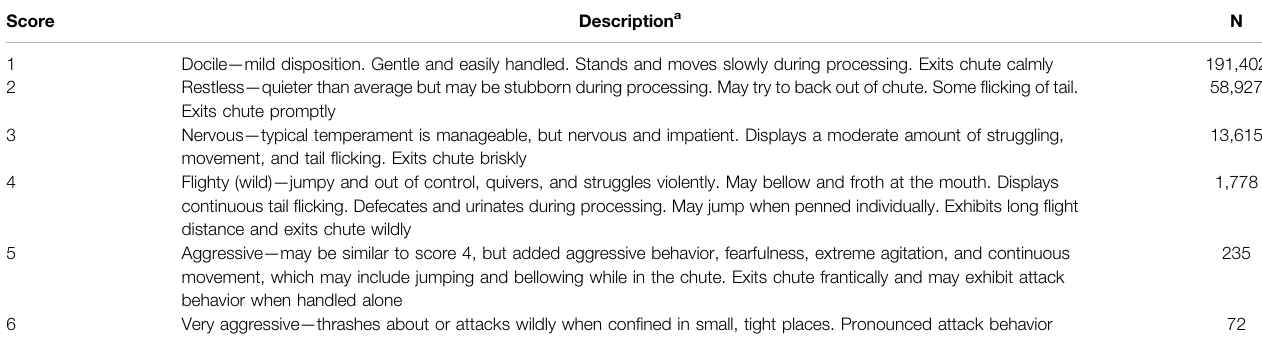
TABLE 1 | Description a of yearling temperament scores and number of animals per level in American Angus cattle. Score Description a